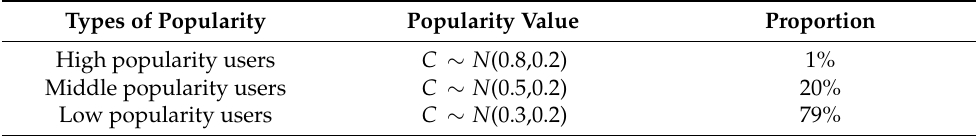
Table 4. Proportion of popularity and distribution of value